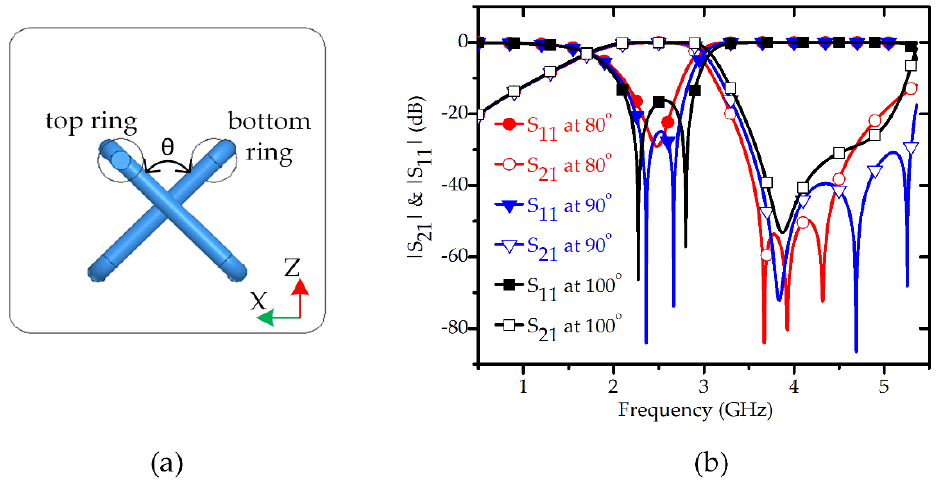
Figure 3. Simulated results at varying angle between SRRs ( a ) Cavity showing angle between split-ring resonators (SRRs); ( b ) Simulated S 21 and S 11 results at angles of 80 ◦ , 90 ◦ and 100 ◦ .